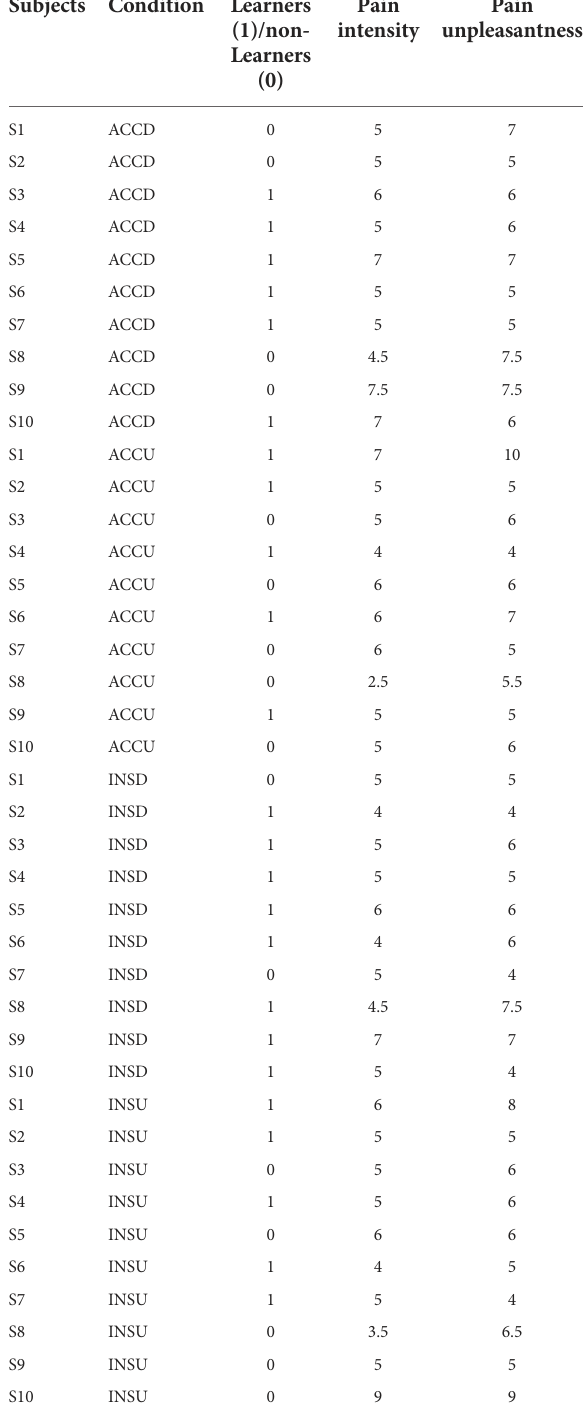
TABLE 4 Pain intensity and unpleasantness ratings for all conditions (ACCD, ACCU, INSD, INSU) for learners (1) and non-learners (0) for trial 6. Subjects